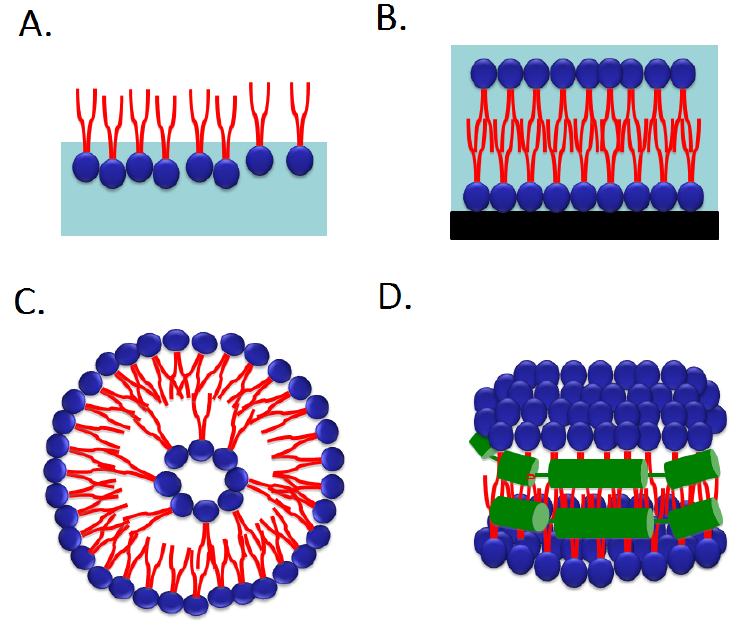
Figure 1. Schematic drawings of ( A ) monolayer, ( B ) supported lipid bilayer, ( C ) liposomes and ( D ) nanodisc. Phospholipids contain two fatty acid tails, shown in red and a hydrophilic head group, shown in blue. Light blue ( A & B ) and black in B represent water and a substrate respectively. Nanodiscs contain membrane scaffold proteins, shown in